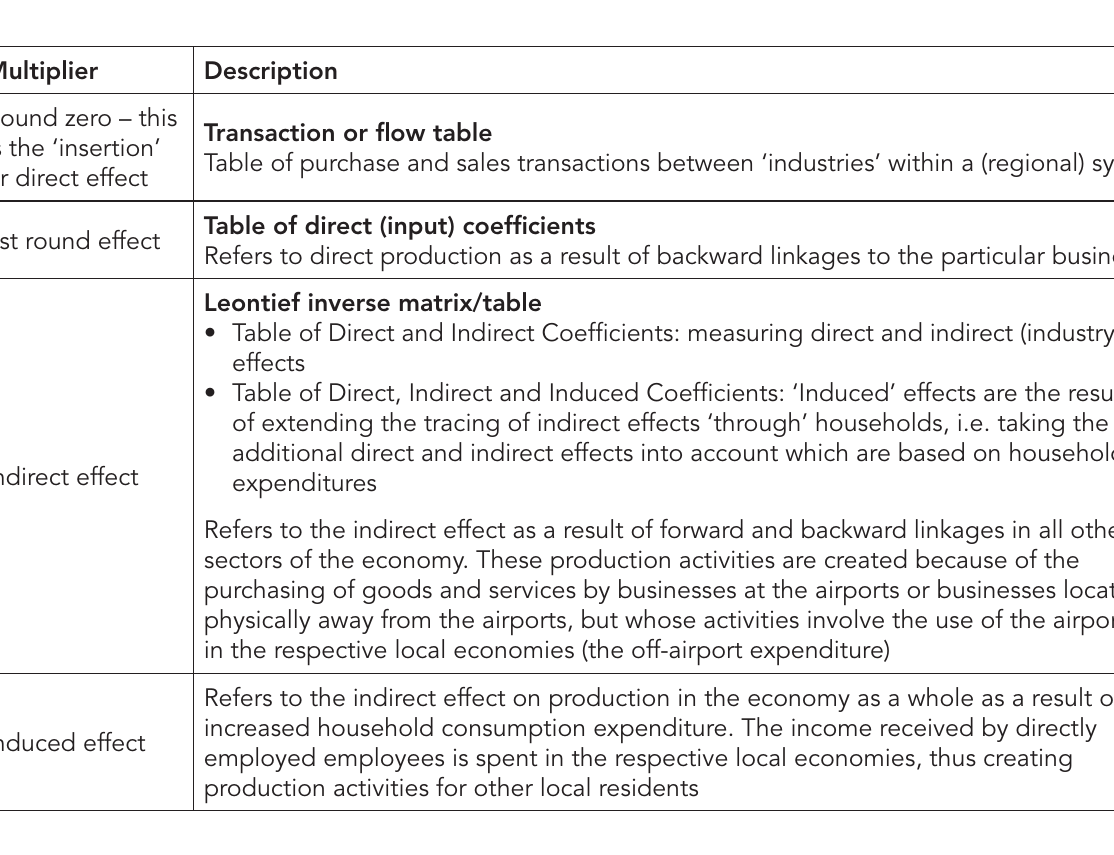
Table II: Different multiplier